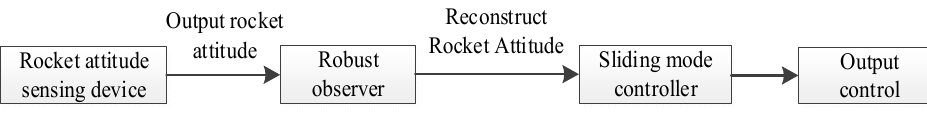
Figure 1. Controller control flow chart.